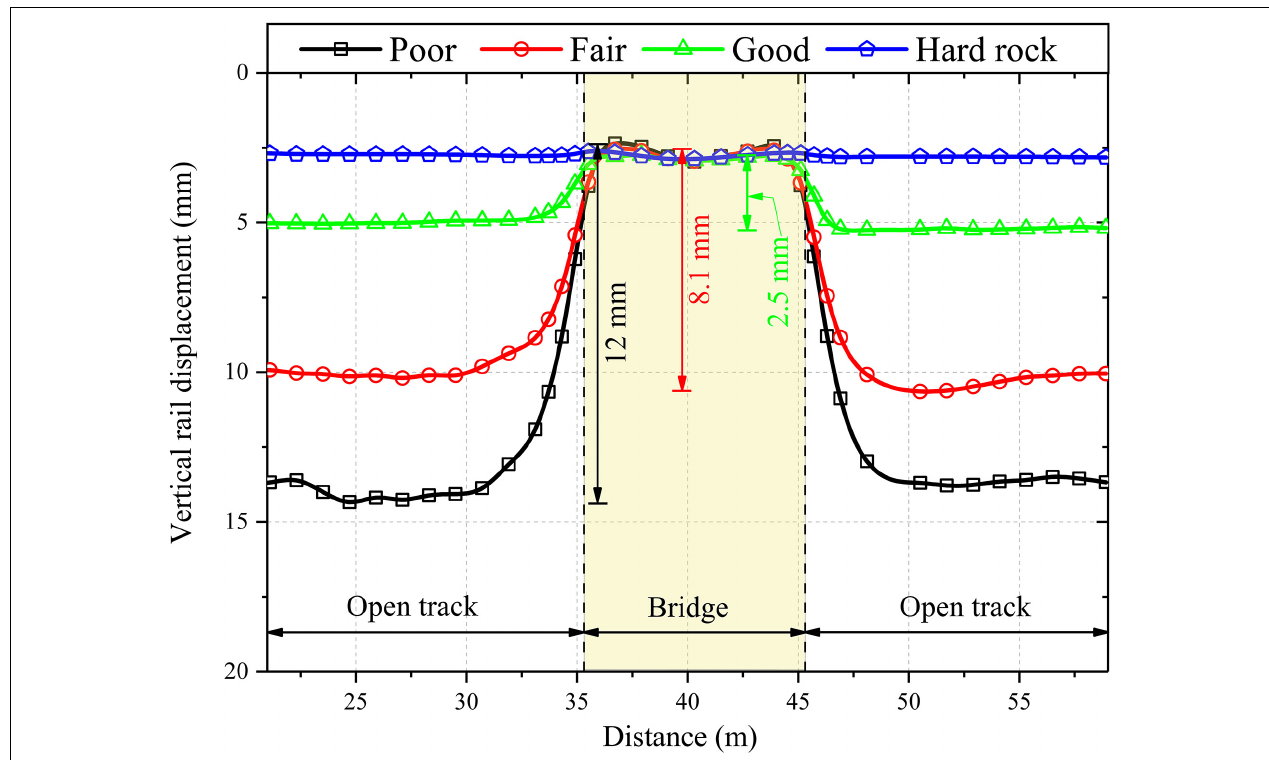
FIGURE 4 | Variation of vertical rail displacement along the length of the track for four different subgrade types.